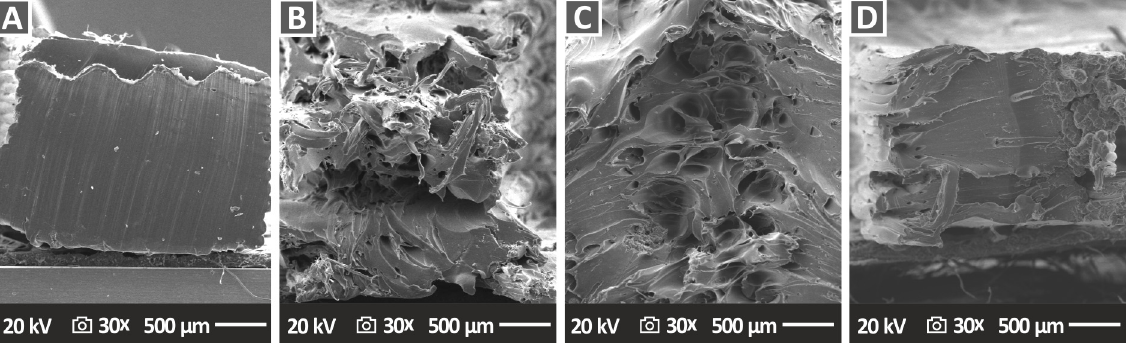
Figure 14. SEM images of the tensile specimens’ fractured surface morphology of ( A ) PA12/Al 2 O 3 (1.0 wt.%), ( B ) PA12/Al 2 O 3 (2.0 wt.%), ( C ) PA12/Al 2 O 3 (3.0 wt.%), and ( D ) PA12/Al 2 O 3 (4.0 wt.%), all at 30× magnification.